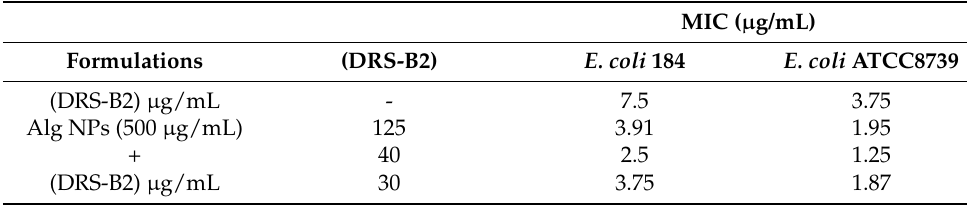
Table 3. MIC values of formulation Alg NPs + DRS-B2 against E. coli strains.